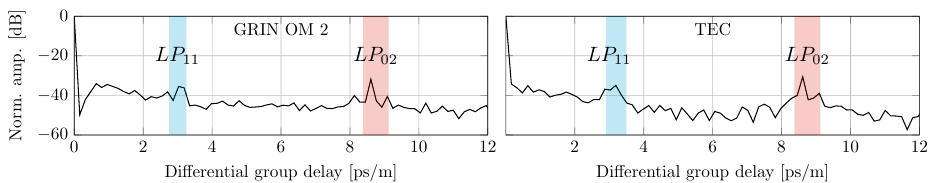
Figure 8. Fourier transform of spectral trances shown in Fig. 7. Positions of LP 11 and LP 02 modes expected from simulations are 3.1 and 8.7